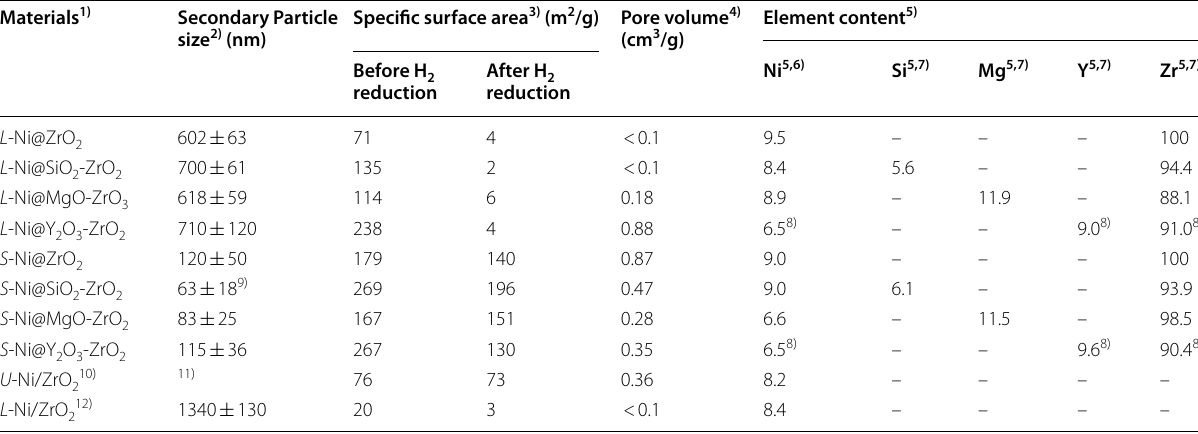
Table 1 Specific surface area, pore volume, secondary particle size, and element contents of Ni catalyst supported on ZrO porous spheres Materials